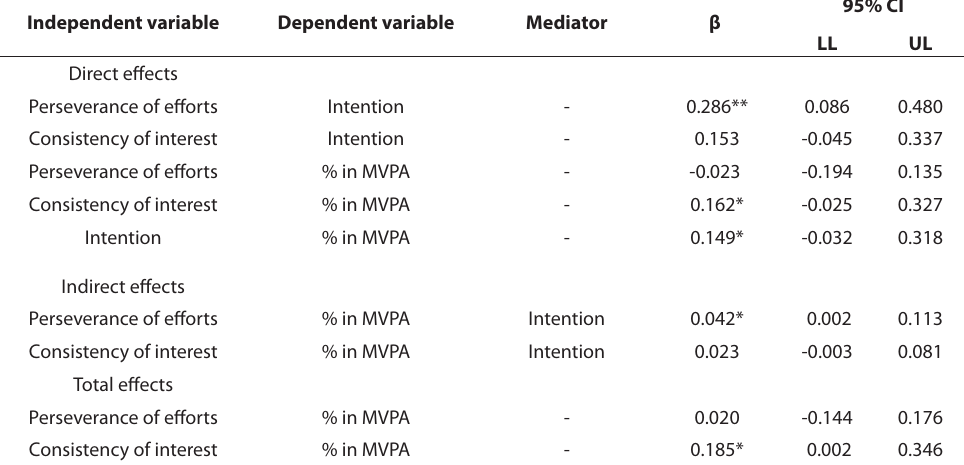
TABLE 3 Standardized parameter estimates and variability statistics for the model of the effect of students’ perceptions of the dimensions of grit on moderate-to-vigorous physical activity with intention as a